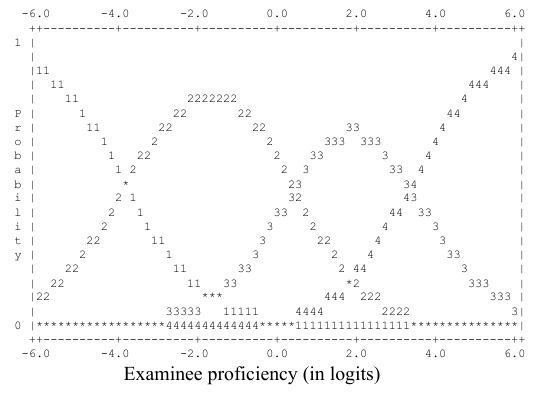
Scale Category Probability Curves for Content